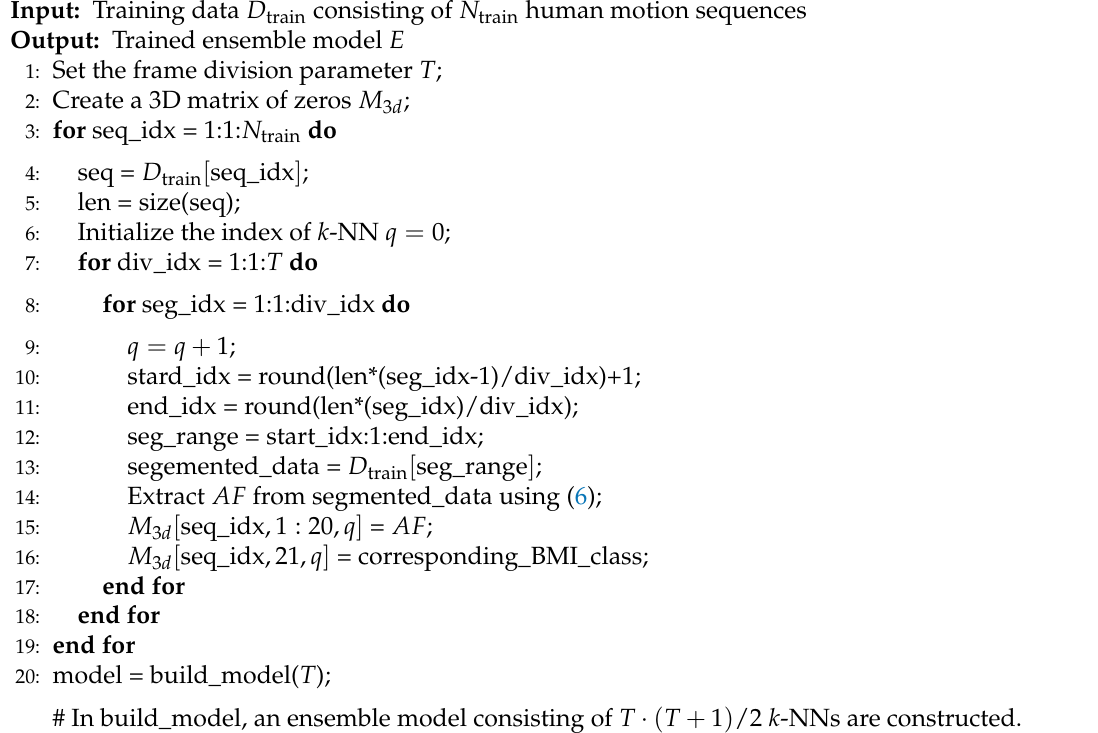
Algorithm 1 Pseudo-code for the proposed ensemble learning algorithm (training phase).